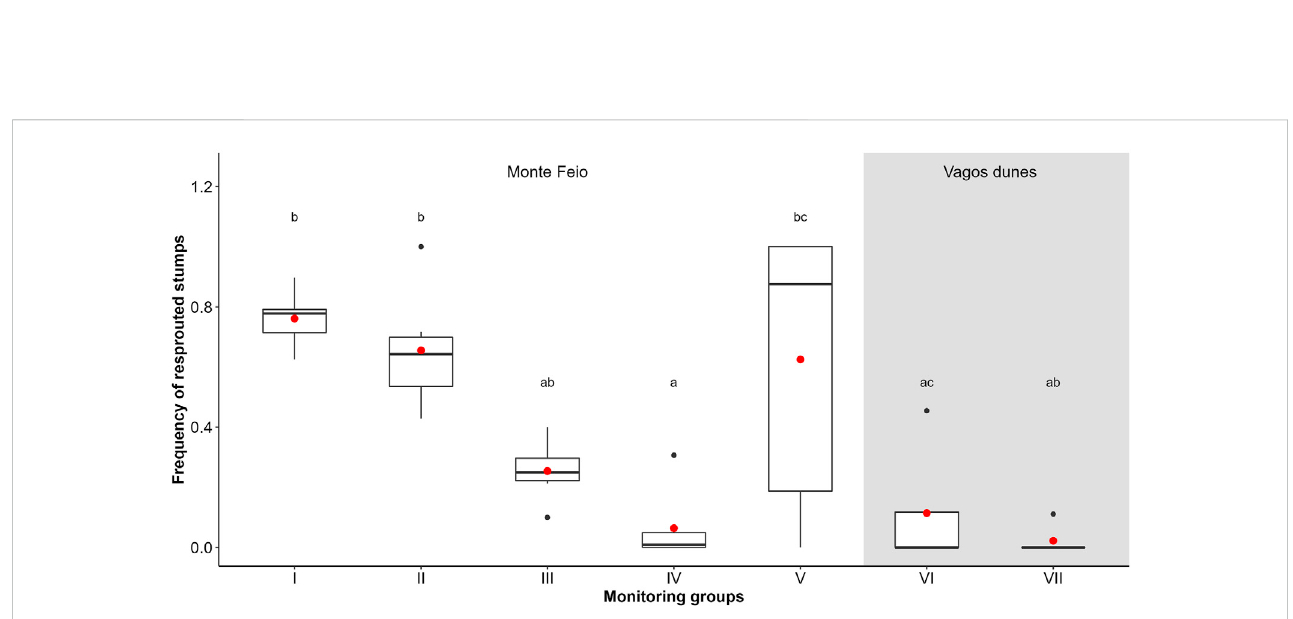
FIGURE 4 Frequency of Acacia longifolia sprouted stumps after the last treatment (T3 or T2 in monitoring group V) on different monitoring groups. Letters above whiskers show results of Tukey post-hoc test. For details on the boxplots, see Figure 2.